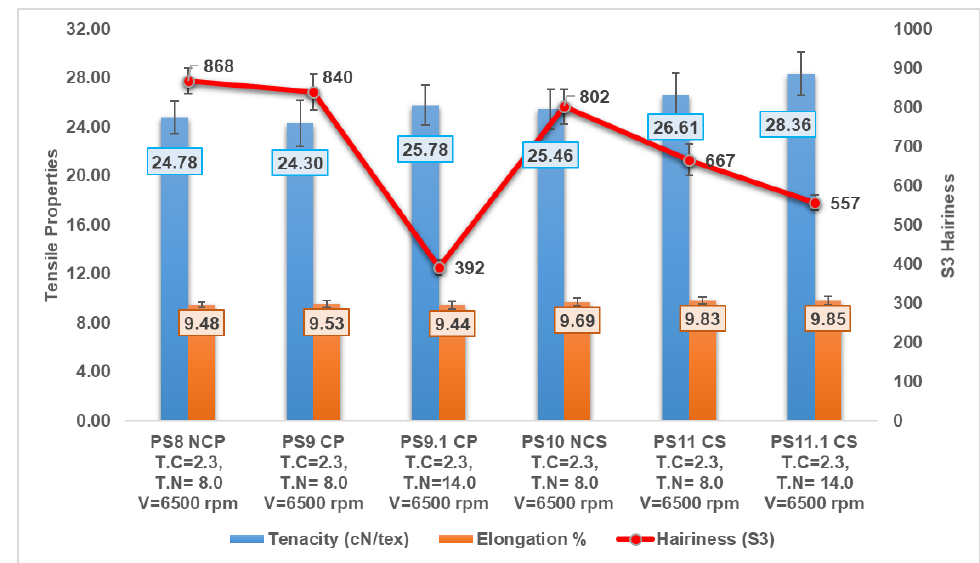
Figure 5. Effect of ARSTs parameters on tensile properties and hairiness of yarns.